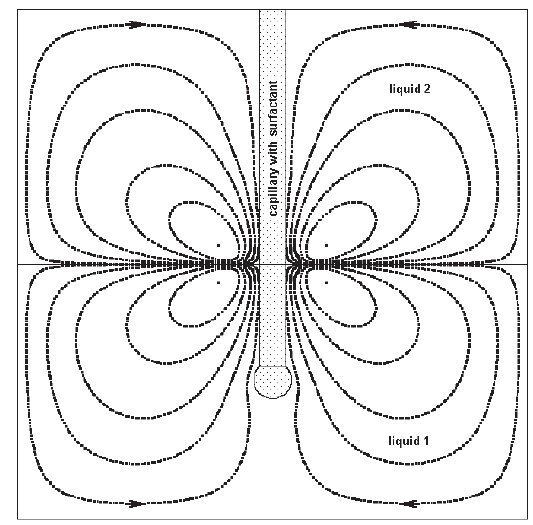
Figure 1: Schematics of the system producing spontaneous oscillations at liquid/liquid interface by dissolution of a surfactant droplet in one of the liquid bulk phases. Reprinted with permission from [7]. Copyright 2005 American Chemical